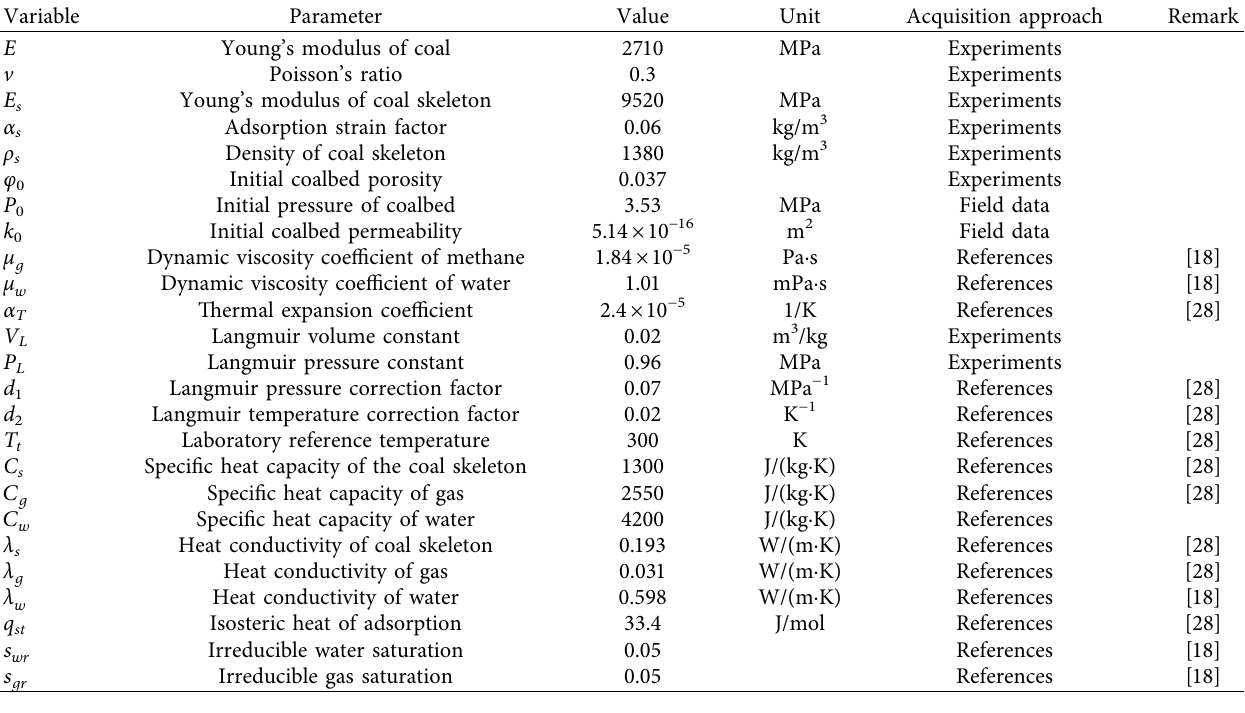
Table 1: Numerical simulation